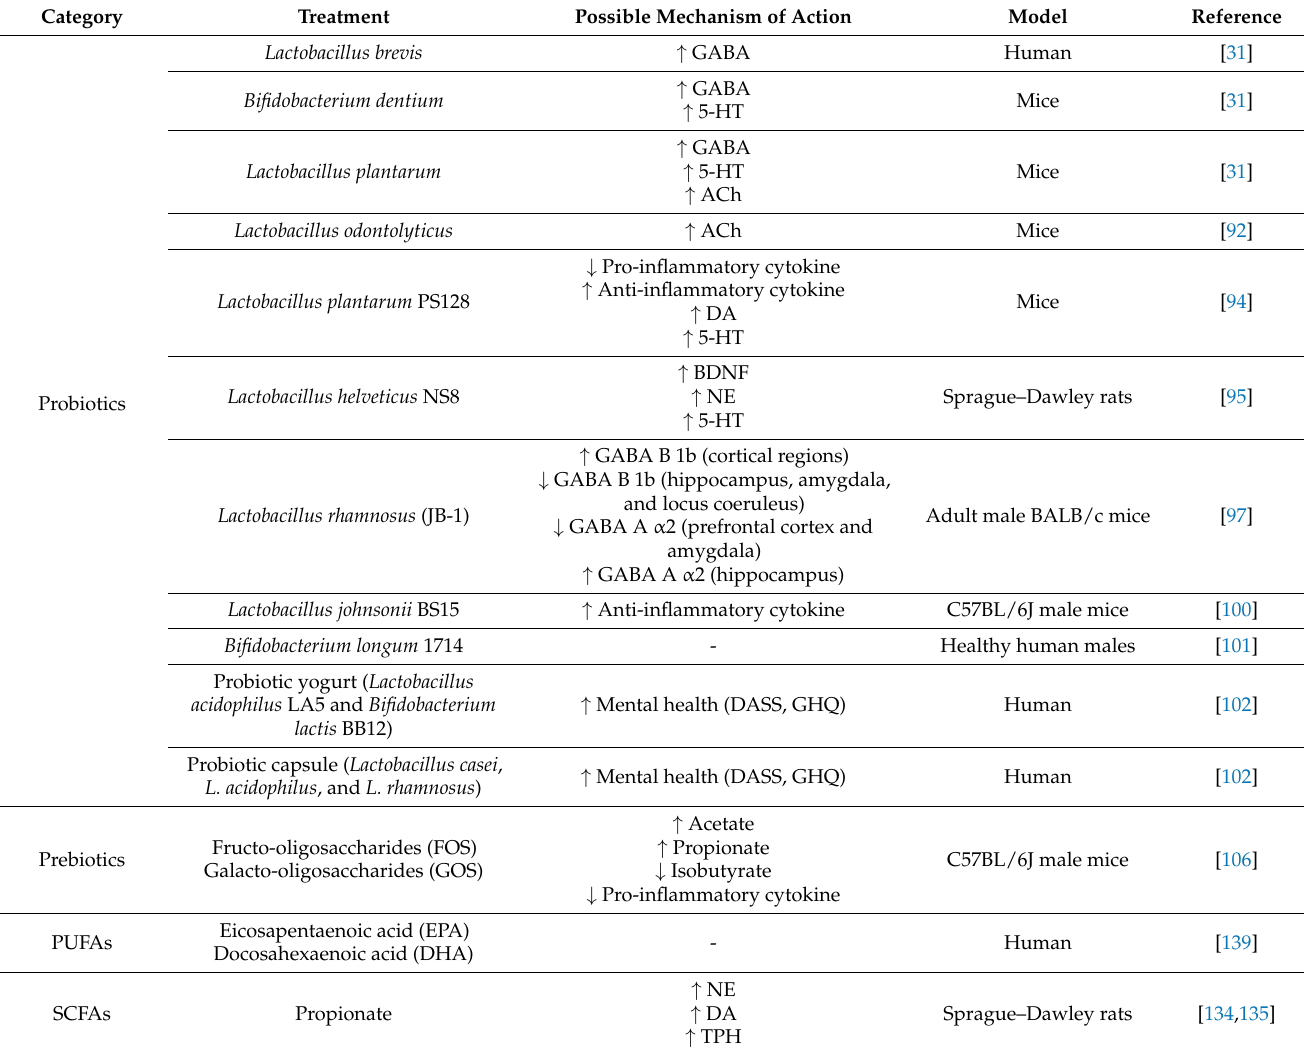
Table 1. Summary of studies on putative antidepressant nutraceuticals, gut microbiota and